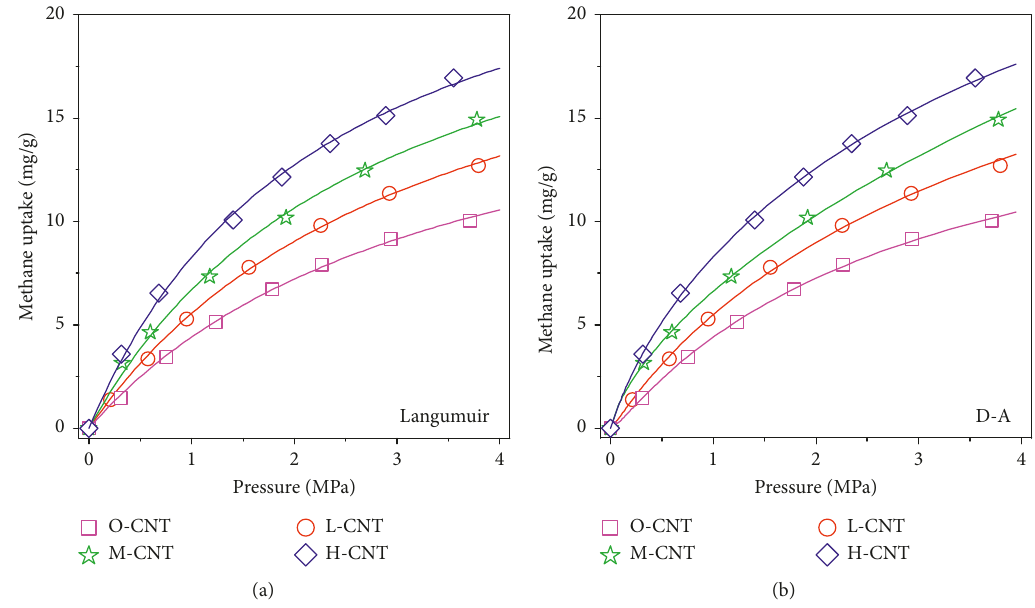
Figure 7: Equilibrium isotherms of methane adsorption on the samples at 298K: (a) Langmuir model; (b) D-A model.